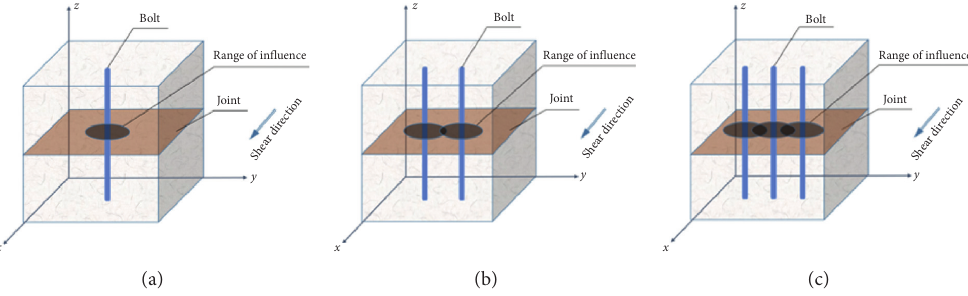
Figure 6: Schematic of the influencing area of bolts. (a) Joint-1-90 ° . (b) Joint-2-90 ° . (c) Joint-3-90 ° . Table 3: Comparison of test results with theoretical calculation